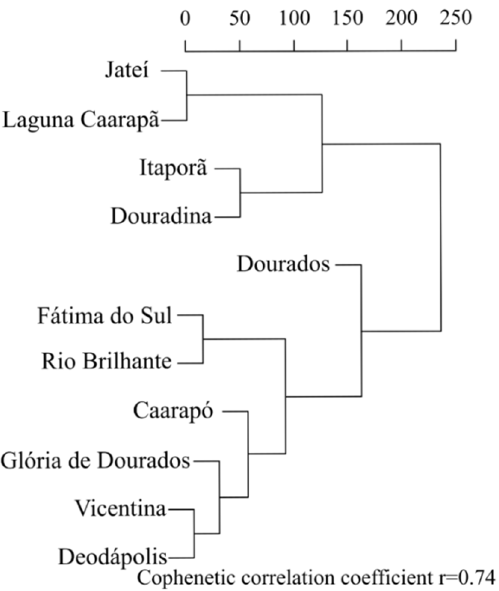
Figure 2. Dendrogram of a cluster analysis of the cities evaluated based on frequency of micronuclei.